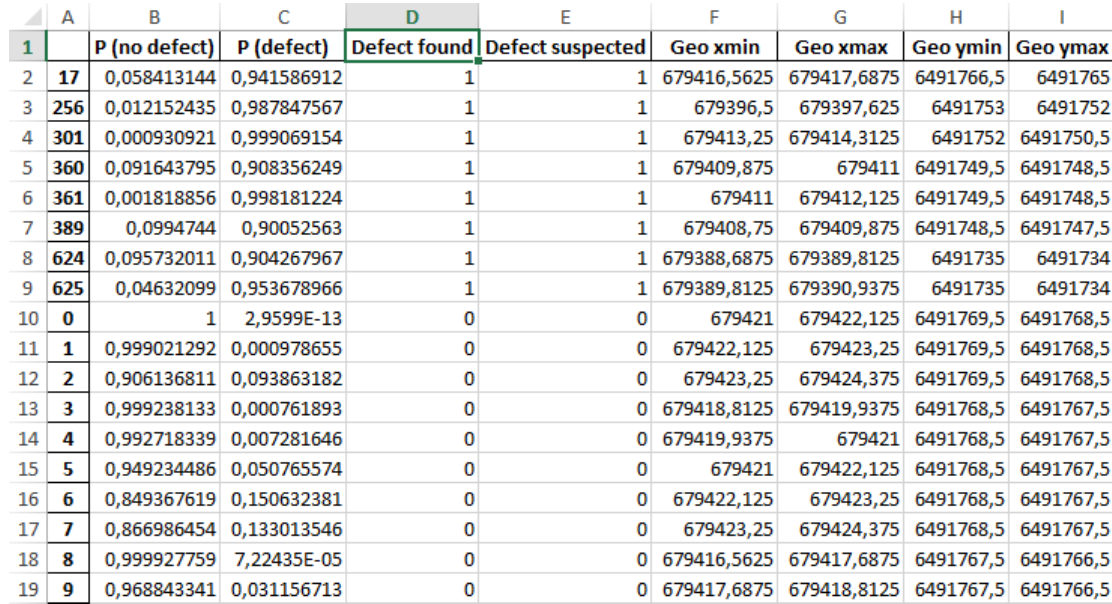
Figure 11. Example image with defect location suggestions generated by the nnapply application. The highlighted area is unmasked, and therefore, only segments fully belonging to this area are considered during partitioning of the image. The segments are extracted at 75% overlap to provide more detail and color coded as red where the intensity of the color corresponds to classifier certainty to having discovered a defect. The regions of the orthoframe having a defect probability over 0.6 are displayed at a higher zoom level.